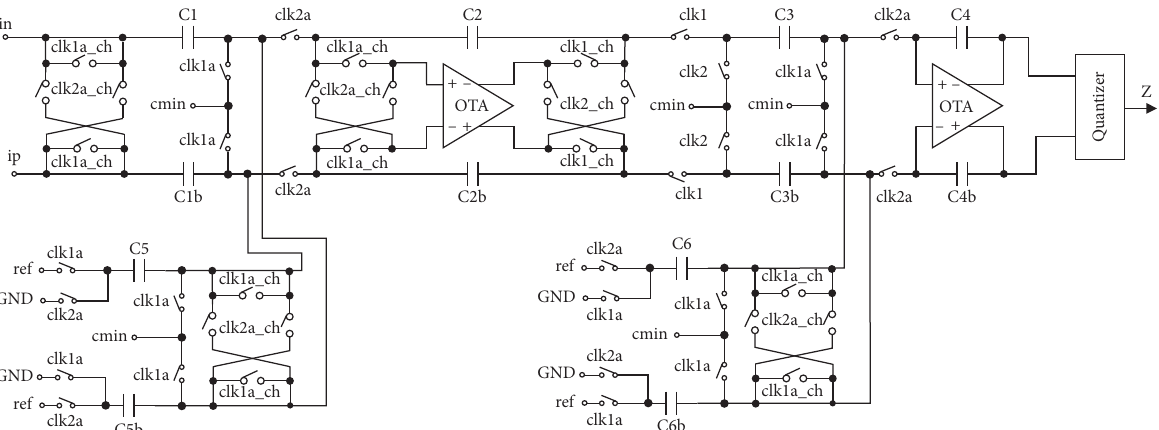
Figure 4: Double chopper-stabilized 2 nd sigma delta